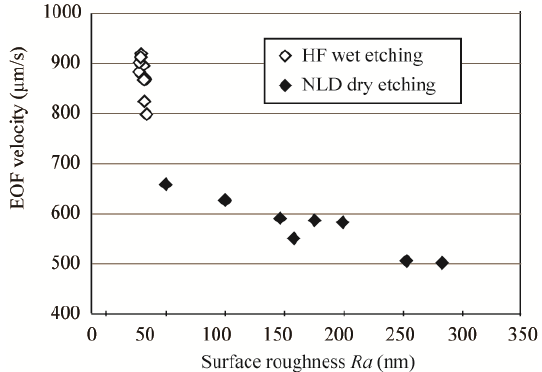
Figure 5. EOF velocity as a function of surface